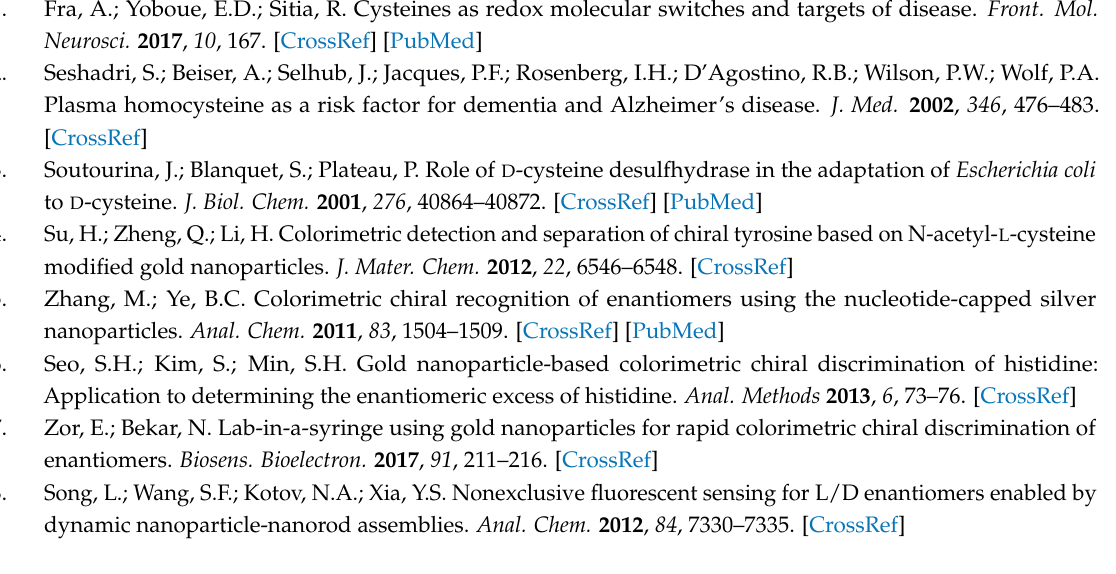
Figure S1: (A) CD and (B) UV-Vis absorption spectra of L -Cys, L -Cys+AgNO 3 and L -Cys capped Ag NPs. Figure S2: (A) CD and (B) UV-Vis absorption spectra of the D -Cys capped Ag NPs prepared at different concentrations of D -Cys. Figure S3: The evolutions of UV-Vis absorption spectra of L -Cys modified Ag NPs with the varied concentration of L -Cys. Figure S4: The evolutions of UV-Vis absorption spectra of L -Cys modified Ag NPs with the varied concentration of L -Cys. Figure S5: CD spectra of Ag NPs in the presence of N-acetyl- L -cysteine and L -cysteine methyl ester. Figure S6: (A) CD and (B) UV-Vis absorption spectra of the L -Cys capped Ag NPs after aging for different time. Figure S7: (A) TEM image of the mesoporous silica coated Ag NP (Ag@mSiO 2 ) before etching. (B) CD spectra of the mixture of Ag@mSiO 2 after etching and L -Cys. Figure S8: The evolutions of (A) UV-Vis absorption spectra of Ag@mSiO 2 - L -Cys with the reaction time. (B) Plot of the CD intensity at 260 nm vs. the reaction time. Figure S9: The evolution of the CD spectra of Ag@mSiO 2 - L -Cys with the varied concentration of L -Cys. Figure S10: The evolution of the CD spectra of Ag@mSiO 2 - D -Cys with the varied concentration of D -Cys. Figure S11: The CD spectra of Ag@mSiO 2 - L -Cys with the concentration of L -Cys of 1.25 × 10 − 5 M. Figure S12: The CD responses of Ag@mSiO 2 in the presence of amino